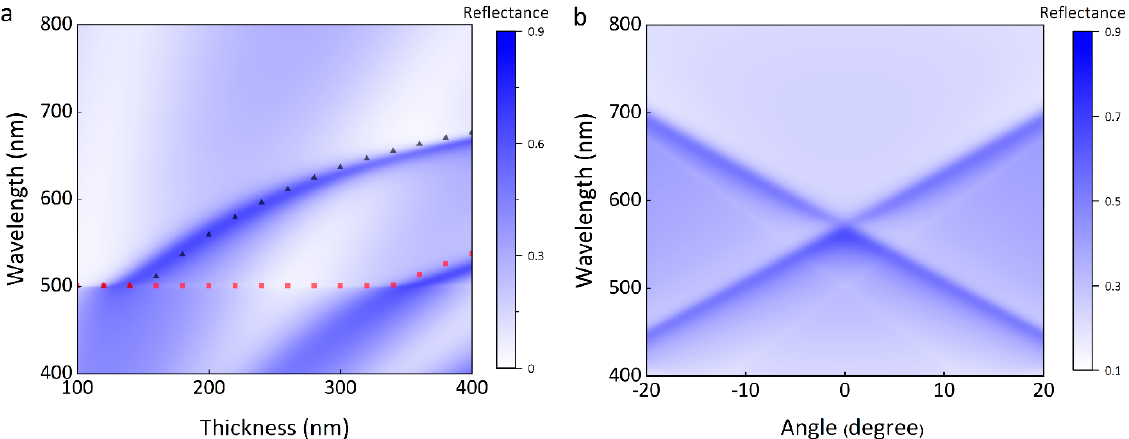
Figure 4. ( a ) The resonance behavior as a function of the thickness. P = 500 nm and the refractive index n is fixed to 1.5. Black triangles ( q = 1) and red squares ( q = 2) are analytical results from Equation (3). In the equation, mode orders were chosen as q = 1 and q = 2, and the corresponding diffraction order m = 3 and m = 1. ( b ) Resonant wavelength as a function of the incident angle θ i . t = 200 nm. Other parameters are the same as ( a